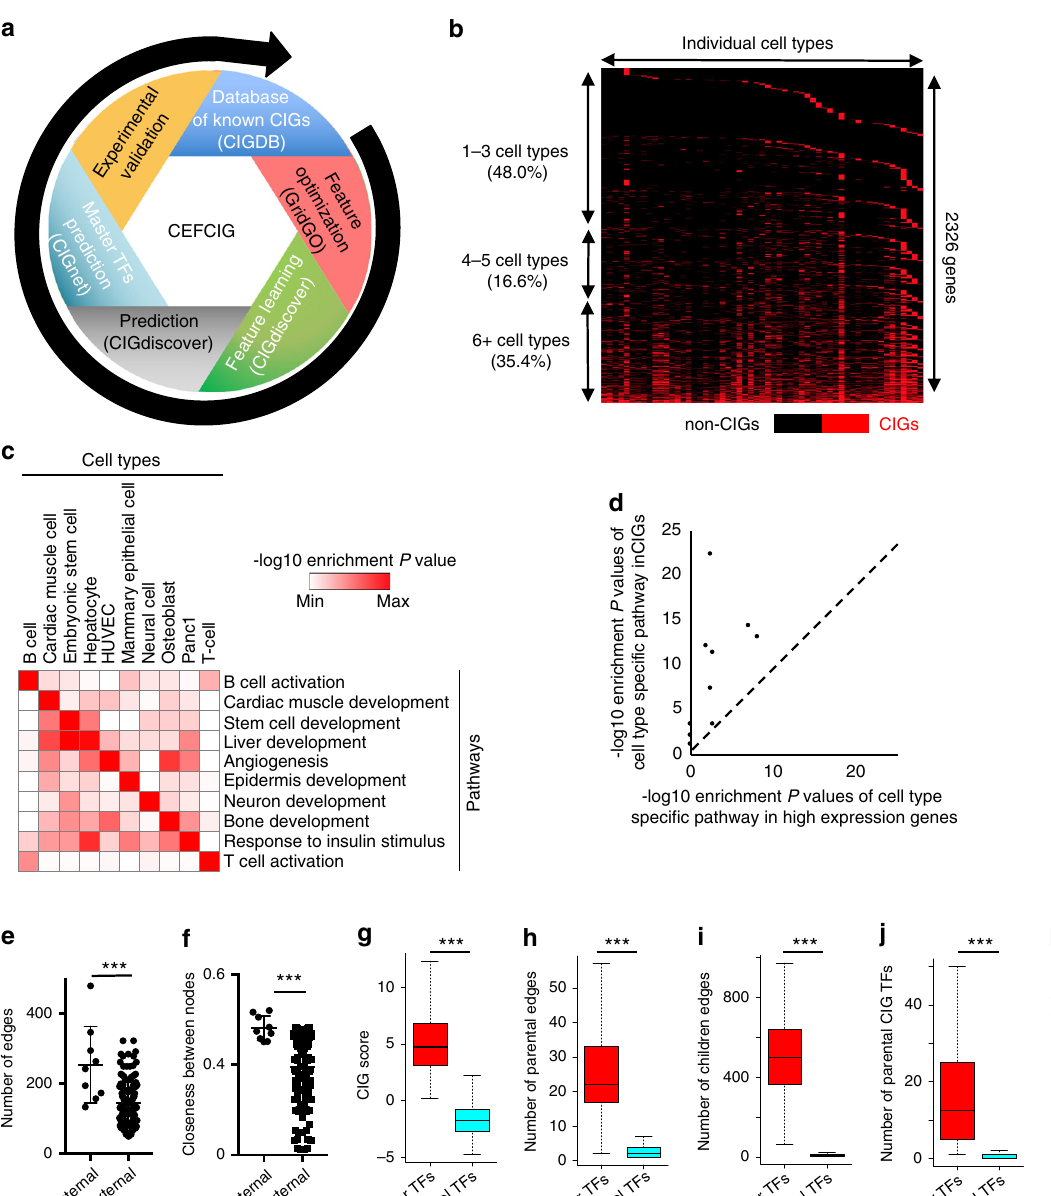
Fig. 4 A comprehensive landscape of CIGs uncovered by CEFCIG. a A cartoon to show CEFCIG framework to uncover cell identity genes and their master transcription factors. b Heatmap to show the speci fi city of CIGs from 57 cell types. c Heatmap to show the enrichment of individual pathways in CIGs de fi ned for individual cell types. d Scatterplot to show − log10 enrichment P -value of cell-type-speci fi c pathway in identity genes and high expression genes for each representative cell type. Each dot indicates one cell type. e , f One-dimensional scatterplots for network edge number ( e ) and closeness score ( f ) between CIGs from the same cell type (internal) or from different cell types (external). g – k Box plots to show CIG score ( g ), number of parental edges ( h ), number of children edges ( i ), number of parent transcription factors ( j ), and number of children transcription factors ( k ) associated with individual transcription factor groups. P -values were determined by Wilcoxon ’ s test ( g – k ). *** P < 0.001. Box plots: center line is median, boxes show fi rst and third quartiles, whiskers extend to the most extreme data points that are no more than 1.5-fold of the interquartile range from the data and ChIP-Seq data for the histone modi fi cations of H3K4me3, H3K4me1, H3K27ac, and H3K27me3. We also de fi ned control genes by requiring that their Gene Ontology, and KEGG. We then further selected a random subset of the control genes, so that number of control genes in the subset is the same as number